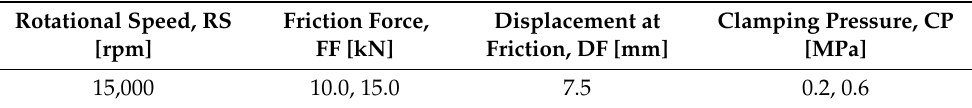
Figure 2. ( a ) Schematic illustration of the pneumatic clamping system and its main elements; ( b ) cross-sectional view of the upper element used to transfer the clamping load. All dimensions are in millimeters. Table 3. Selected joining conditions of Direct-Friction Riveting.